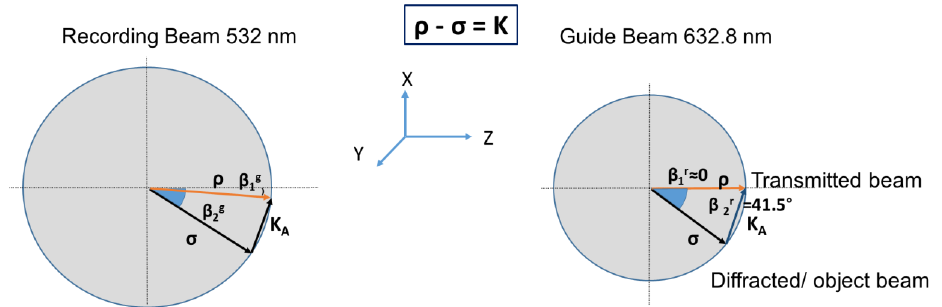
Figure 1. Ewald’s sphere and recording with green light ( left ) and read out with red light ( right ) geometries waveguide coupled element designed for normal incidence of red light.